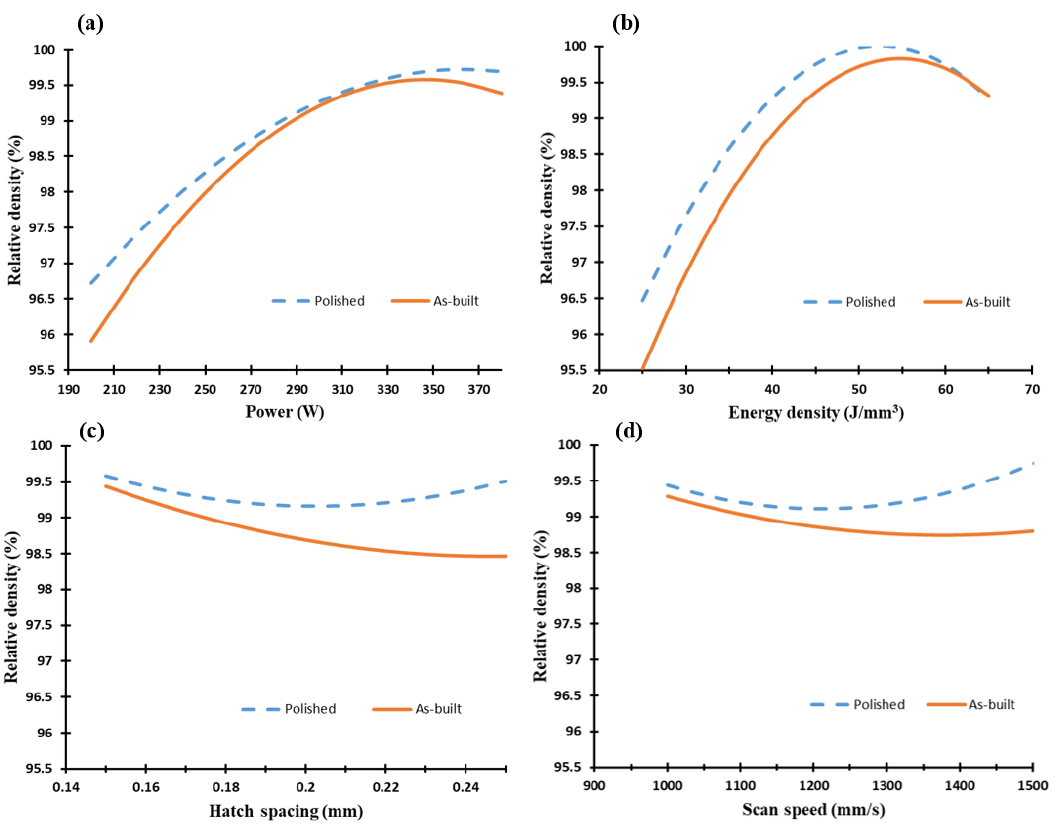
Figure 5. Relative density of the as-built AlSi10Mg samples vs. ( a ) laser power (W), ( b ) energy density (J/mm 3 ), ( c ) hatch spacing (mm), and ( d ) scan speed